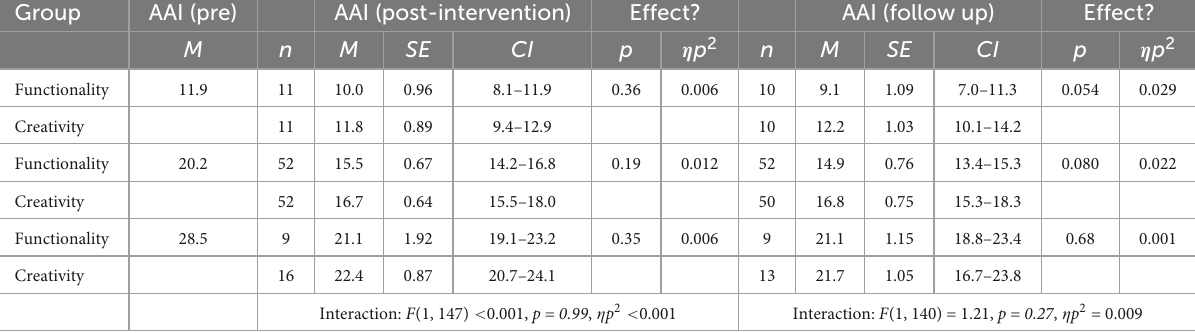
TABLE 7 Summary of completer analysis for appearance anxiety (AAI), including estimated marginal means and effects of the intervention at baseline values of AAI one-standard deviation below the mean, the mean, and one-standard deviation above the mean, as well as the interaction effect (baseline AAI and study arm) on AAI at post-intervention ( n = 151) and 1-month follow up ( n = 144). Group AAI (pre)